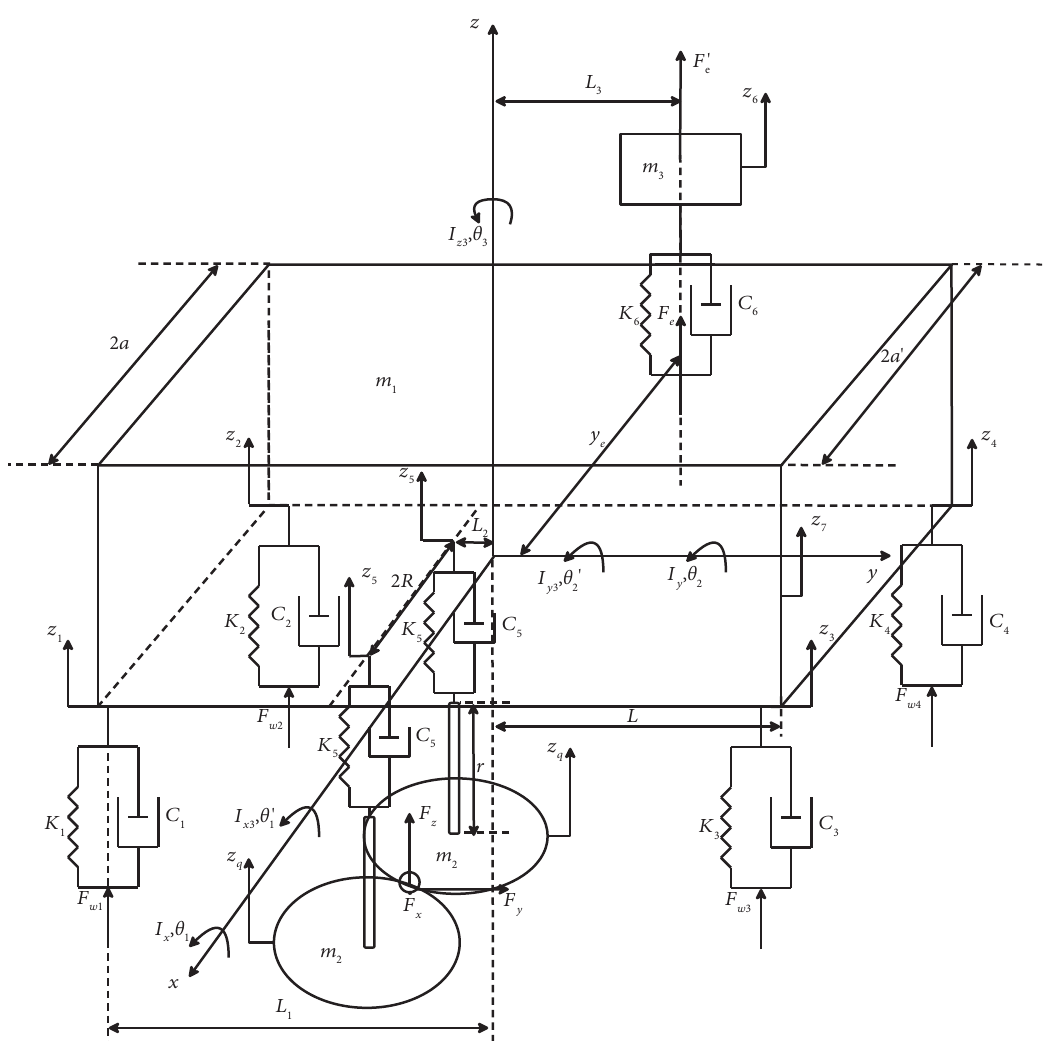
Figure 5: The dynamics model of the